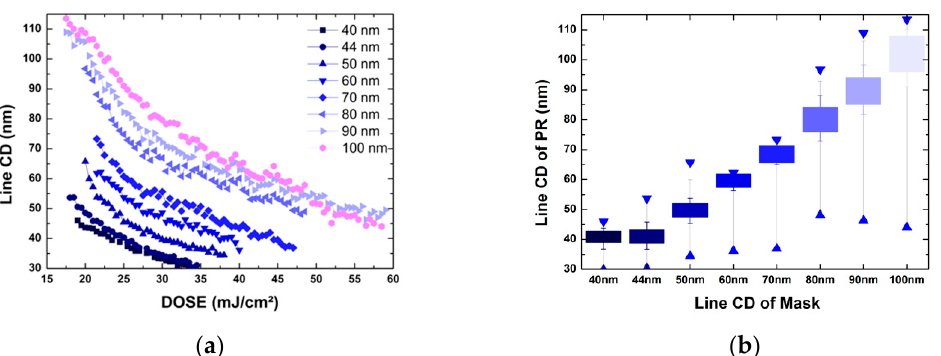
Figure 2. ( a ) Line CD of PR dependence on to intensity (DOSE) in 1:1 L/S Pattern accoridng to line CD of mask. ( b ) Box range is the effective CD variation with ±5% of the target (mask) CD, and stick CD of mask. ( b ) Box range is the effective CD variation with ± 5% of the target (mask) CD, and stick range is the line standing range. range is the line standing